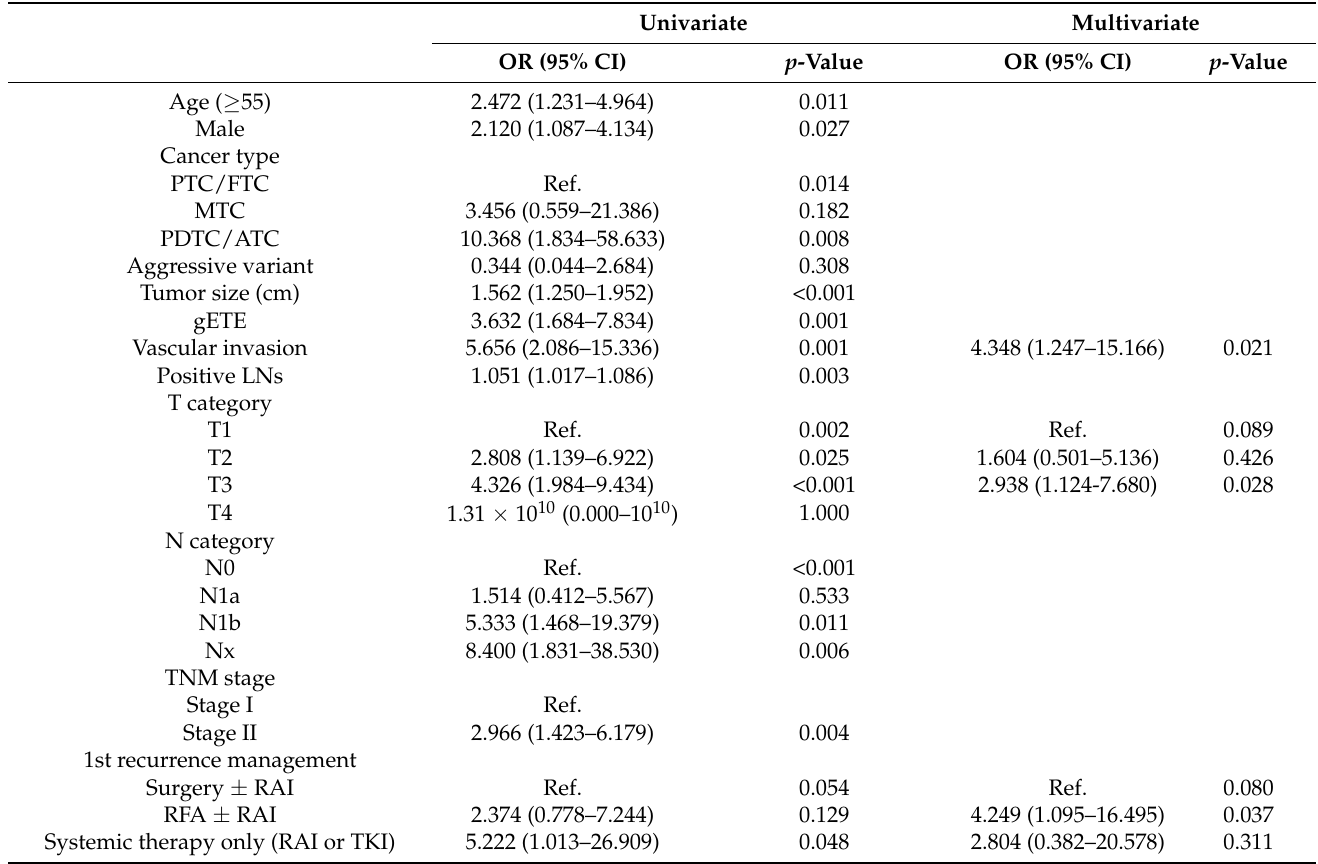
Table 2. Logistic regression analysis of risk factors for re-recurrence according to 1st op outcomes.